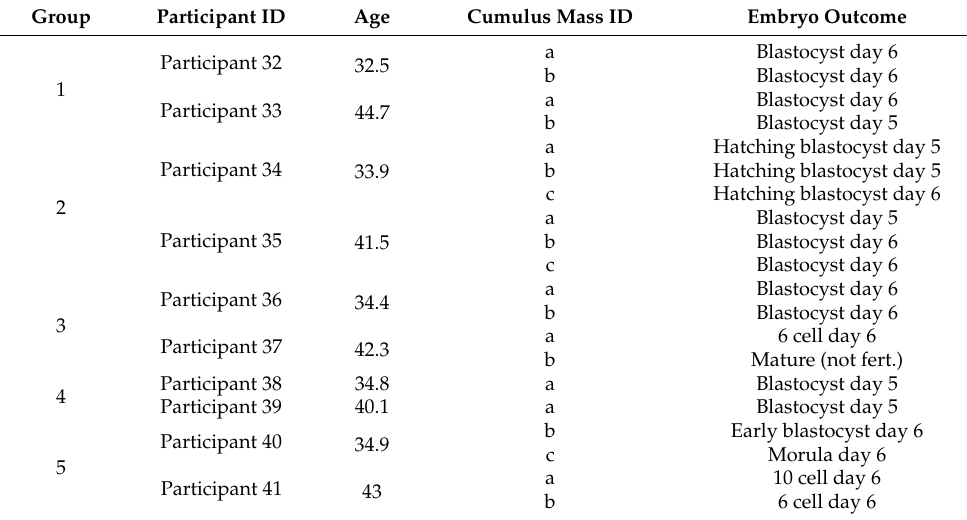
Table 3. Young vs. old participant cumulus cell information.